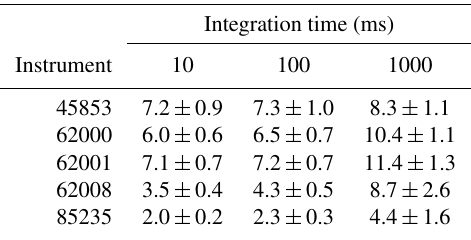
Table 2. Mean noise N dark of spectroradiometer dark signals as a function of integration time and corresponding standard deviations of N dark in a wavelength range of 280–650nm. Examples of dark spectra are shown in Fig. 3.